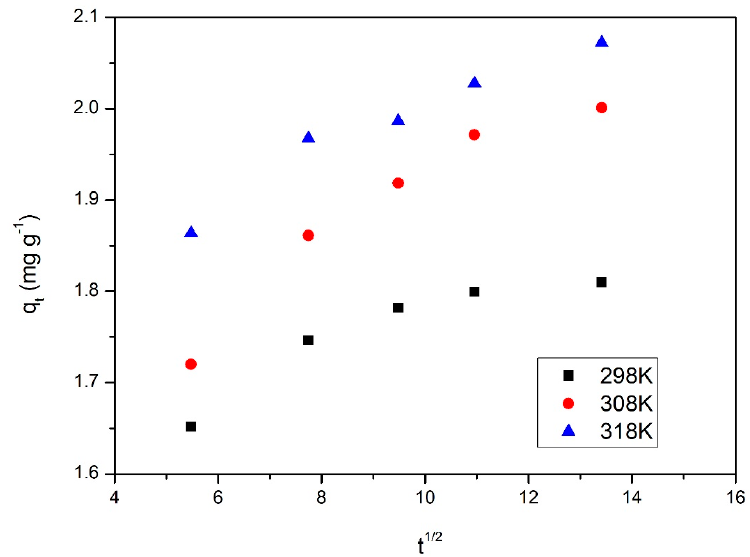
Figure 12. Intraparticle diffusion models for three different temperatures.